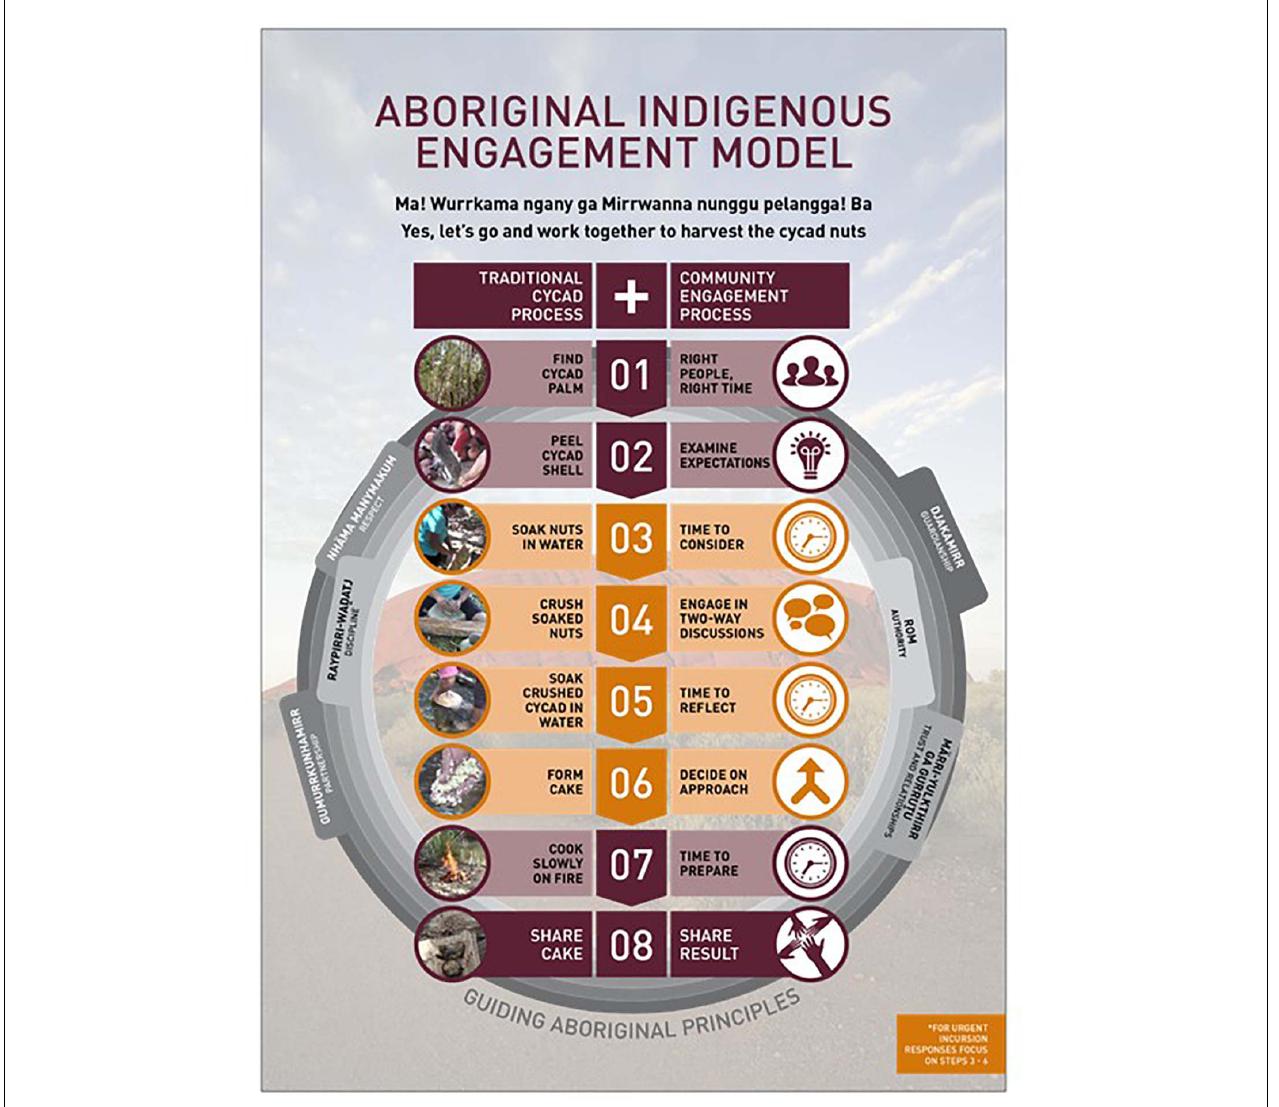
FIGURE 2 | Aboriginal indigenous engagement model developed as a framework of how to engage and work with Australian Arborgines. The framework is based on the traditional Aboriginal process of removing toxins from cycad ( Macrozamia spp.) nut kernals prior to eating, as a model for successful engagement. In this framework, essential steps have been identified for urgent incursion responses. If one of these steps is missed, the toxins will not be removed from the resulting nuts; similarly, if we take short cuts in the engagement process then we will not remove all doubt and suspicion. This framework was developed by Linda Ford, Ruth Wallace, Kathy Guthadjaka, Pawinee Yuhun, Chloe Ford and Johanna Funk (Charles Darwin University).